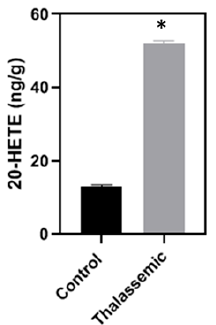
Figure 4. Overexpression of CYP4A and CYP4F in Hbb th3/+ mice. Relative mRNA levels (%) of ( A ) CYP1A/YWHAZ and ( B ) CYP4A/YWHAZ. Representative Western blot of ( C ) CYP4A/HSC70 and ( D ) CYP4F/HSC70, with the respective densito- metric quantification in liver tissues of control and Hbb th3/+ mice. ( E ) Immunohistochemistry staining of liver tissue sections at 20× for CYP4A expression in control mouse, and CYP4A expression in Hbb th3/+ mice. Scale bar represents 40 μ m. Values are the means ± SEM from 4 different mice in each group ( n = 4). * p < 0.05 versus control. C.V: central vein.